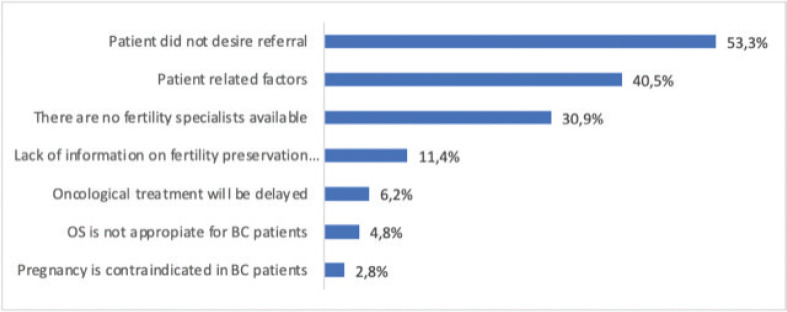
Reason for not referring patients to a fertility specialist. (n: 210). OS = Ovarian stimulation; pt = patient; BC = breast cancer.